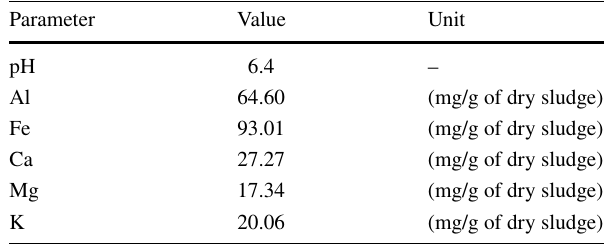
Table 2 Characteristics of water treatment residuals